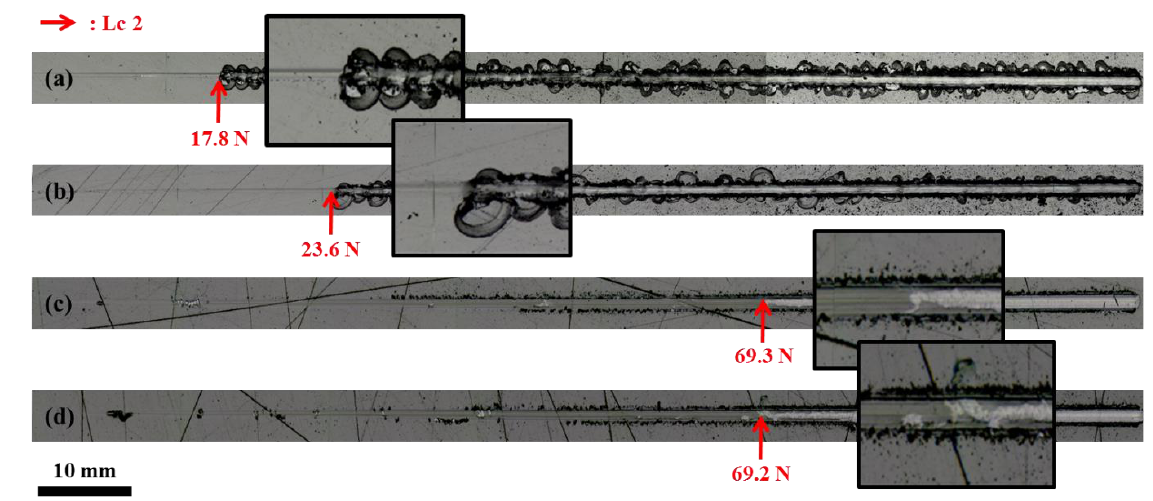
Figure 4. Optical microscopy images of the scratch tracks of the CrAlN coatings with ( a ) no interlayer, ( b ) CrZrN interlayer, ( c ) CrN interlayer, and ( d ) CrN/CrZrSiN interlayer.